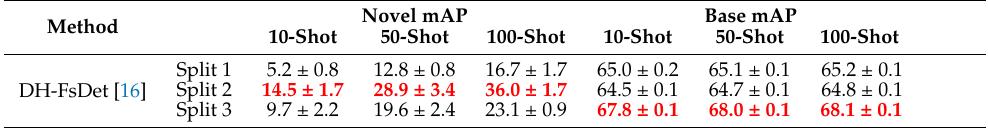
Table 8. FSOD performance (AP50 in %) on the base and novel classes of the iSAID dataset . The base/novel splitting can be found in Table 1. Red indicates the top highest accuracy. DH- FSDet is a transfer learning-based few-shot detector.